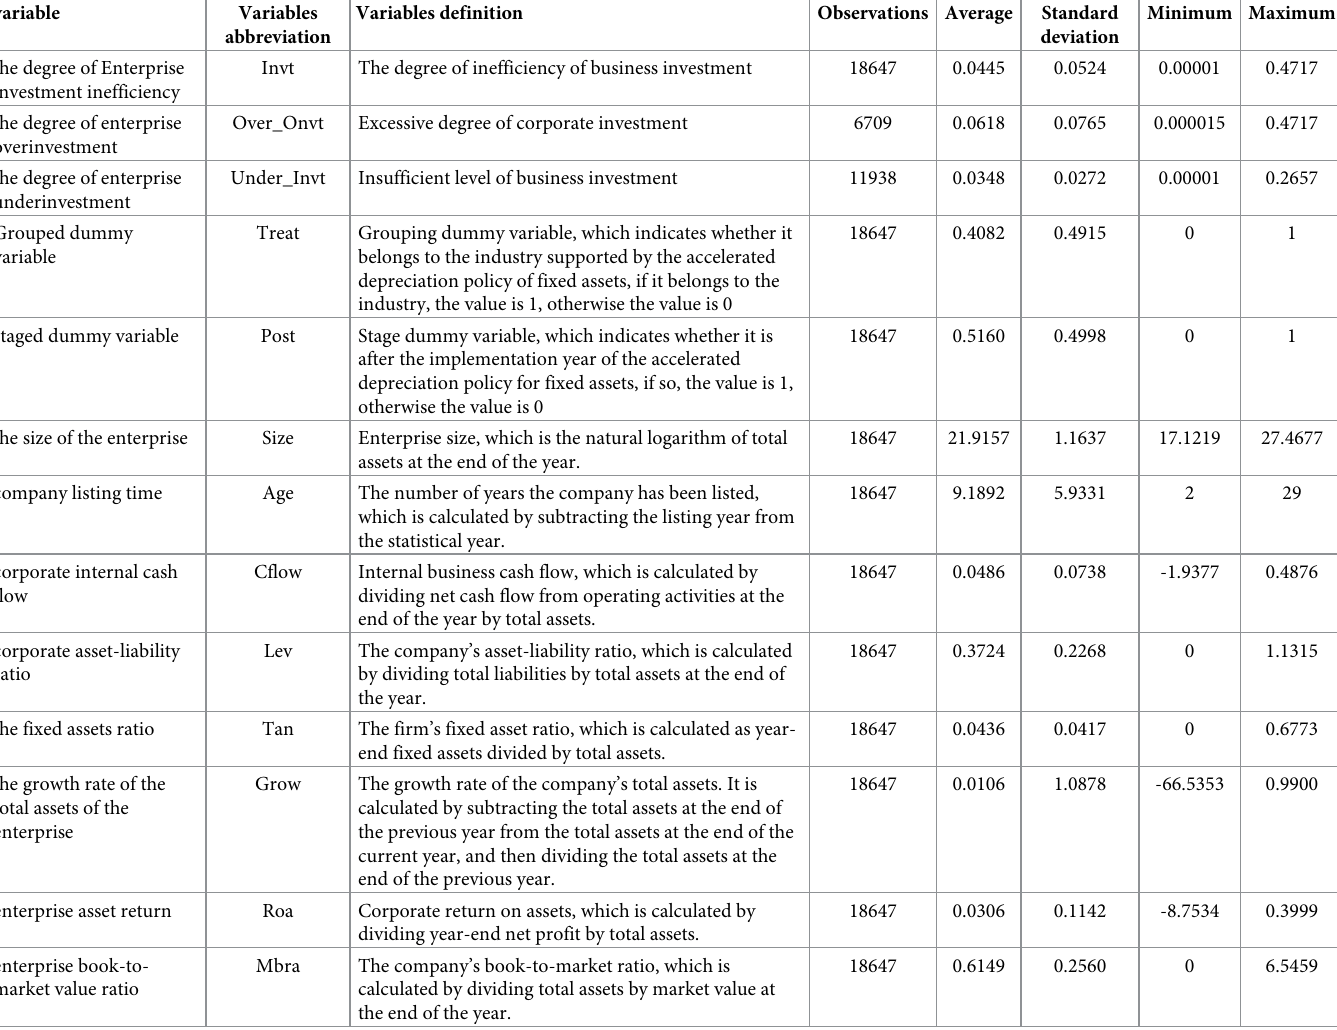
Table 1. Descriptive statistics of main